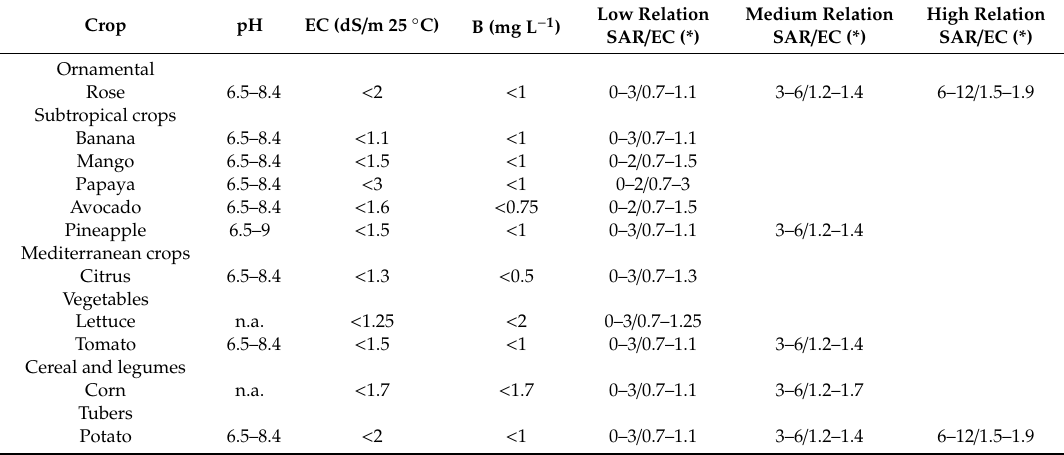
Table 4. Recommended water quality parameters per crops of irrigation water by the Integrated Production Regulations of the Canary Islands.